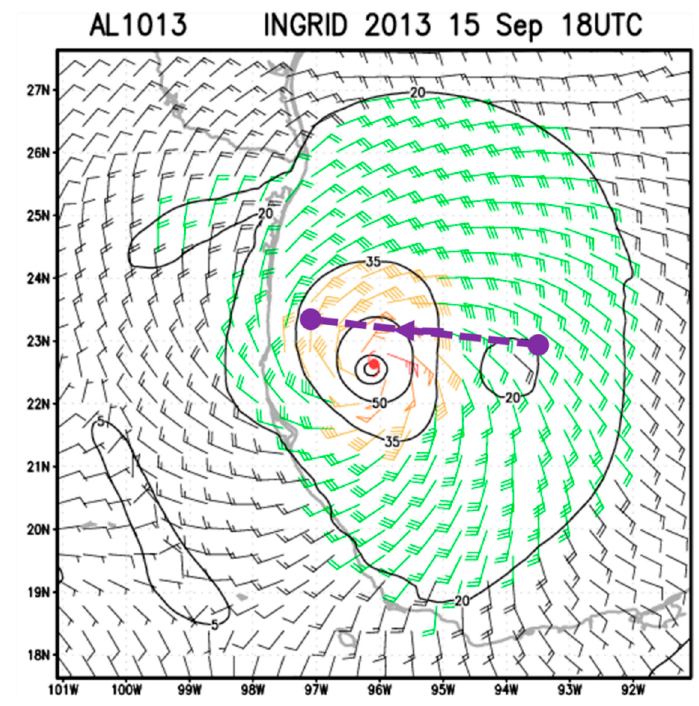
Figure 8. Overlay display of HIWRAP flight observation path and Multiplatform Satellite Surface Wind Analysis product.